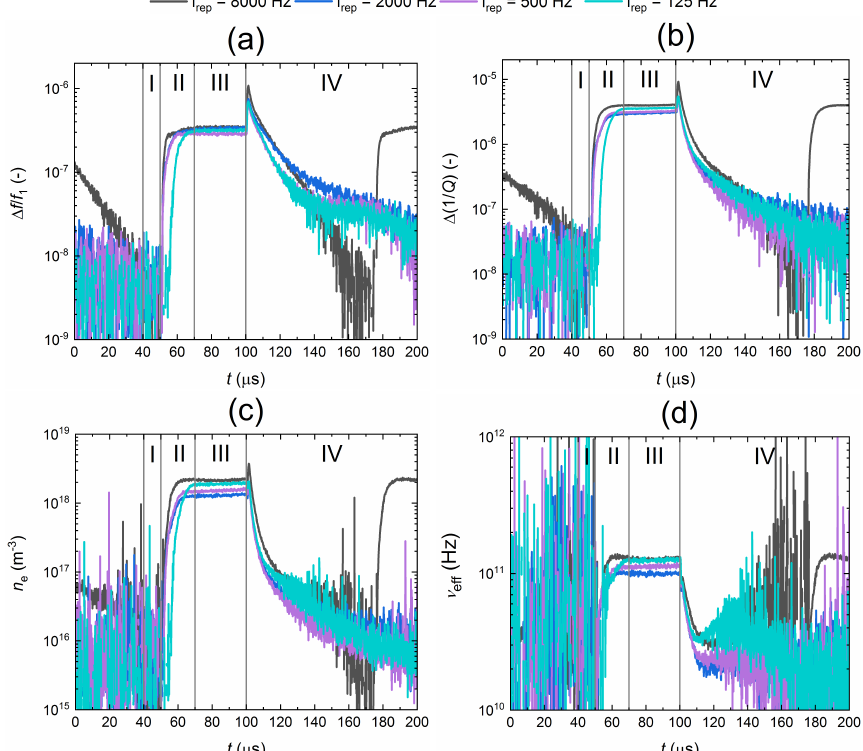
Figure 5. Temporal evolution of ( a ) the relative frequency shift ∆ f / f 1 , ( b ) the change of the reciprocal quality factor ∆ ( 1/ Q ) , ( c ) the electron density n e , and ( d ) the effective electron collision frequency ν eff for different plasma repetition frequencies f rep . The Roman numerals (I, II, III, and IV) indicate the four distinctive plasma phases in the experiment. B. Platier, T. J. A. Staps, M. van der Schans, W.